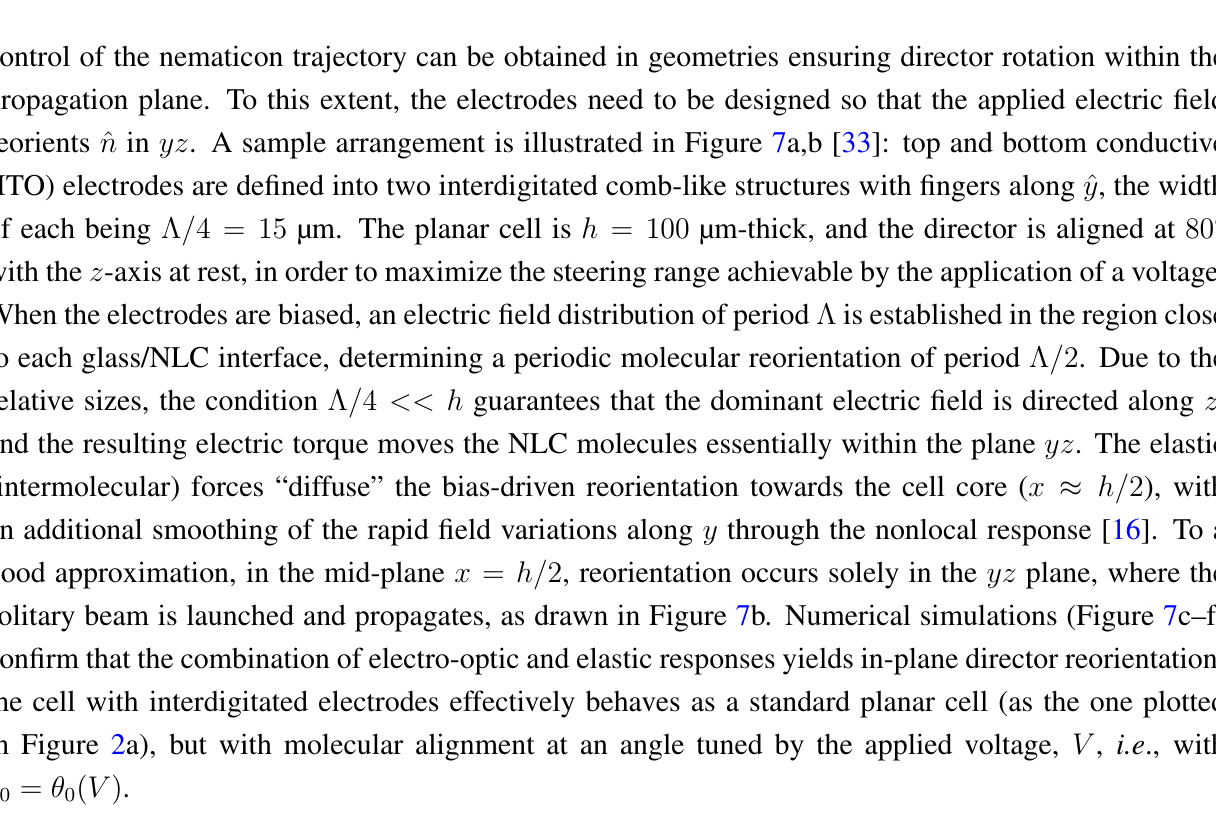
Figure 7. ( a ) Electrode configuration. The main component of the electric field is along z , thus inducing director rotation towards z and coplanar with yz ; ( b ) Side view. The black dashed lines represent the electric field lines. The solid blue lines indicate the director distribution inside the sample, with no x component in the mid-plane; ( c – f ) Numerically calculated reorientation for ( c ) V = 1 ; ( d ) 2 ; ( e ) 3 and ( f ) 5 V, respectively, showing a flat director profile ( θ ) in the cell core x (cid:25) h/ 2